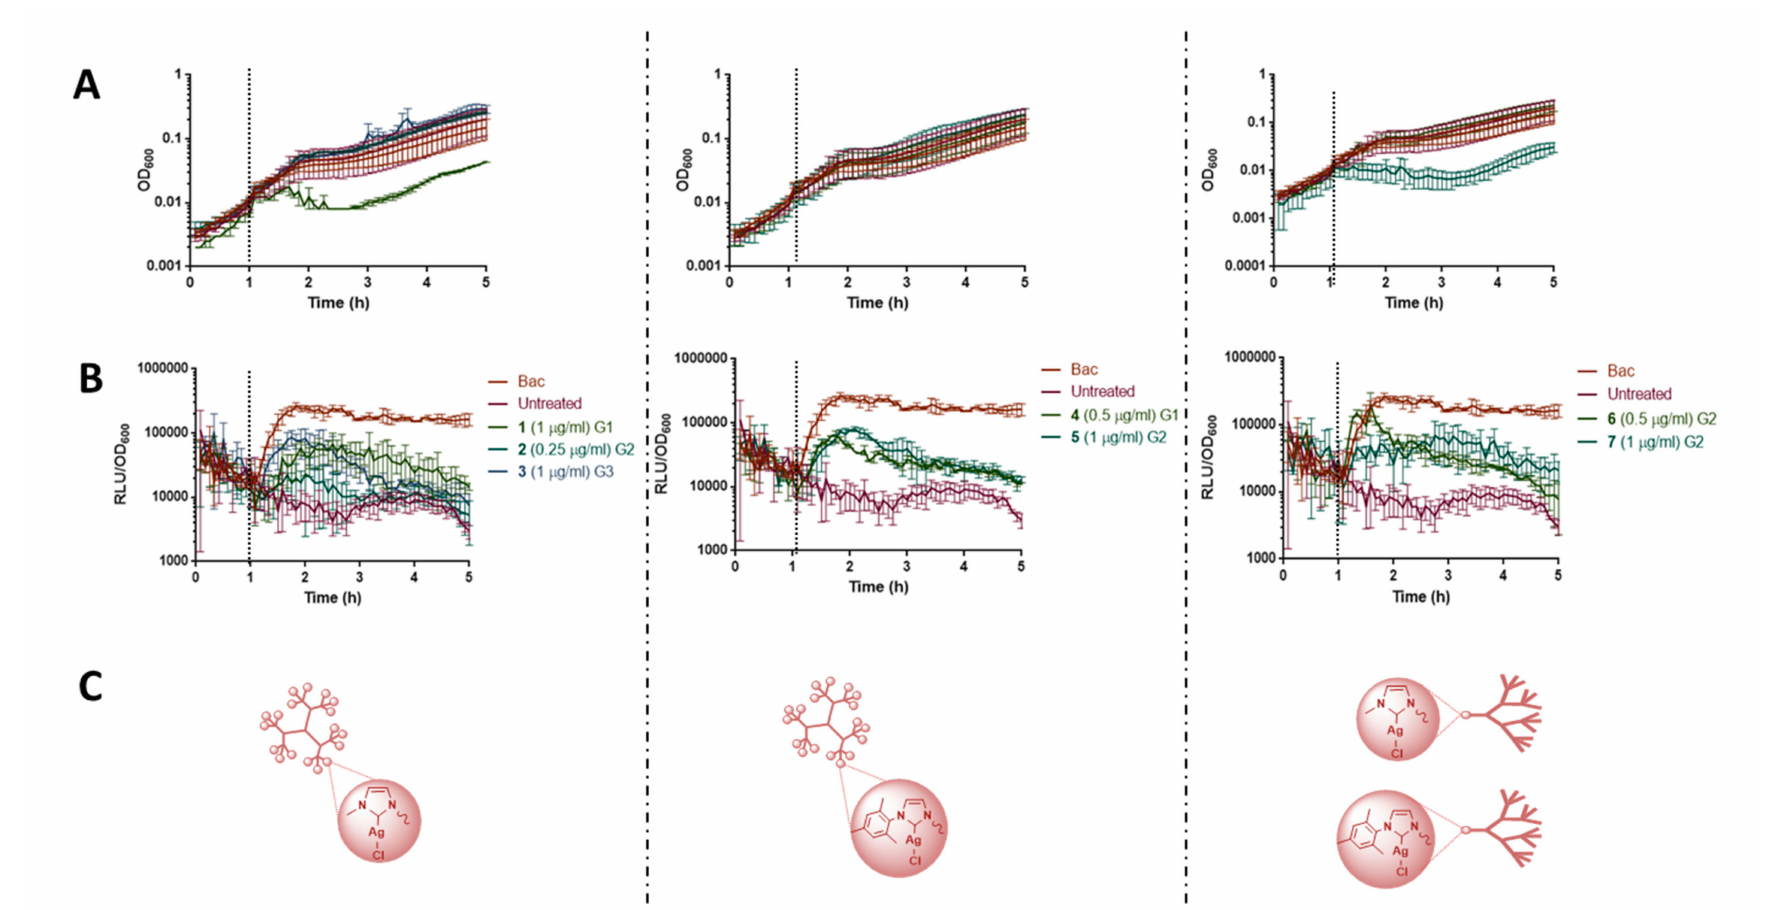
Figure 2. P PsdA biosensor induction in the presence of dendritic systems containing Ag(I)-NHC. ( A ) OD 600 values; ( B ) relation between luminescence / OD 600 ; ( C ) Schematic representation of compounds. Dash lines at 1h in graphs A and B denote the addition of